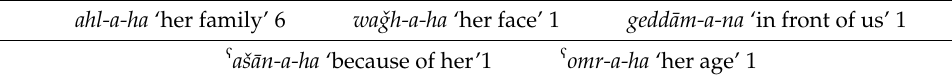
Table 2. Trochaic occurrences in nouns and prepositions.